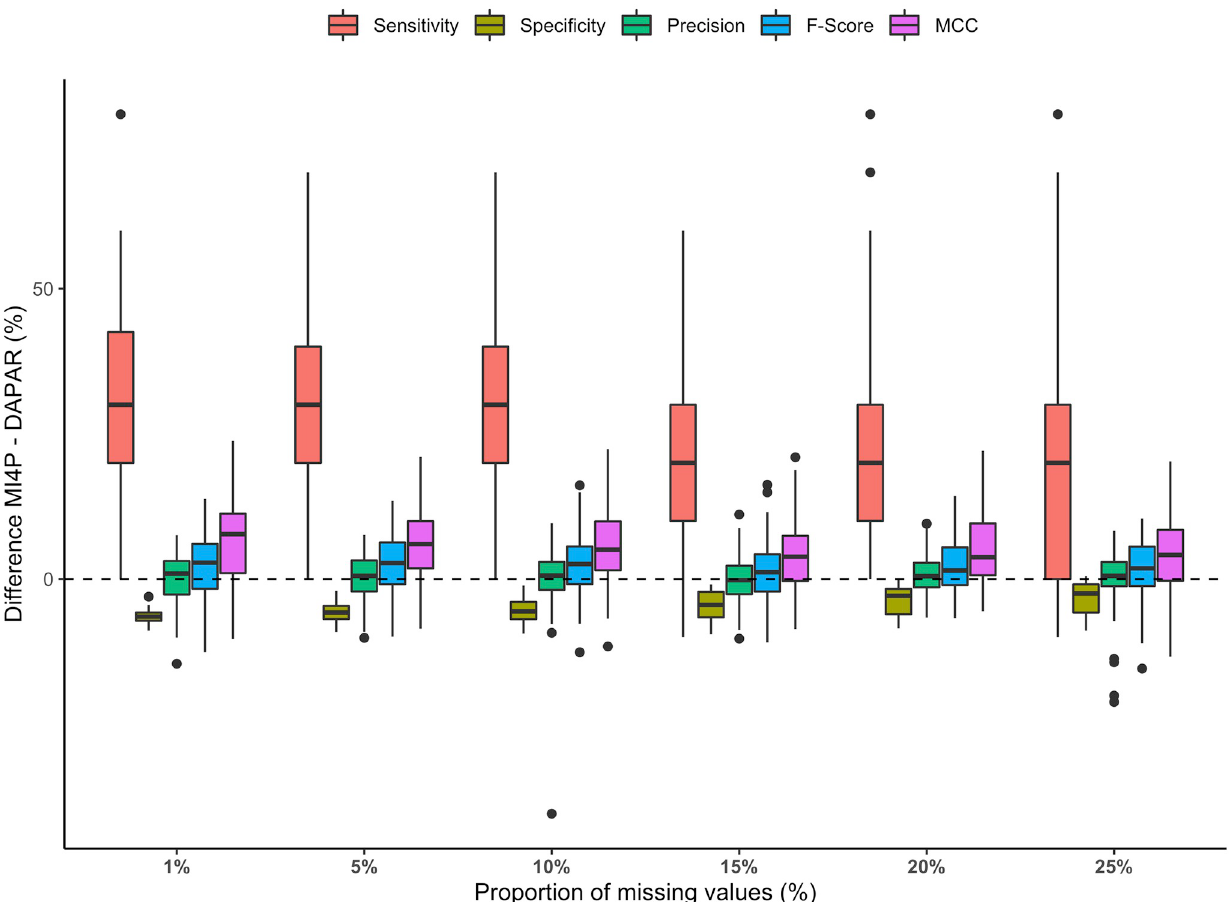
Fig 9. Distributions of differences in sensitivity, specificity, precision, F -score and Matthews correlation coefficient for the third MAR set of simulations. Missing values were imputed using the maximum likelihood estimation method.